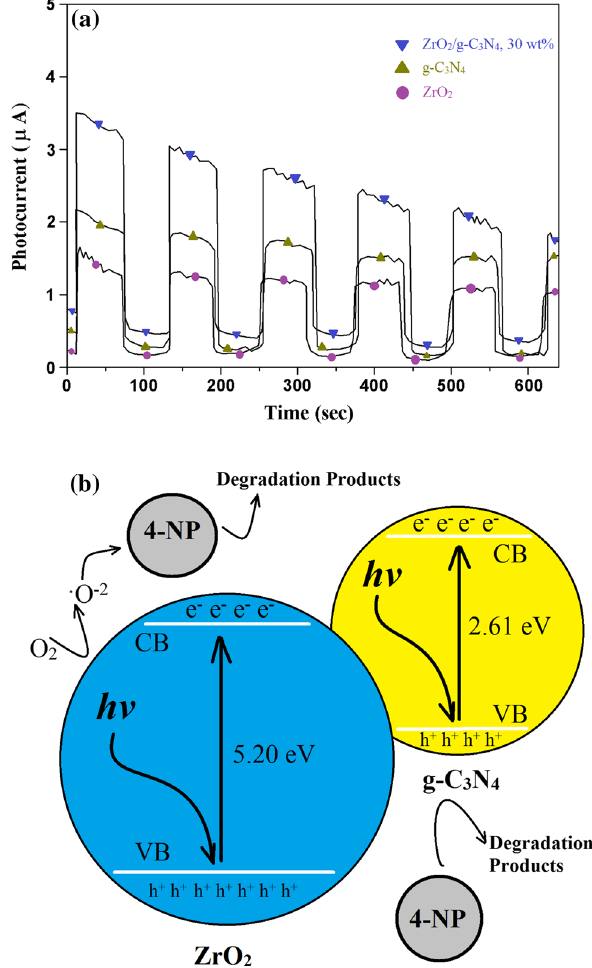
Fig. 6 a Transient photocurrent responses of pure ZrO and